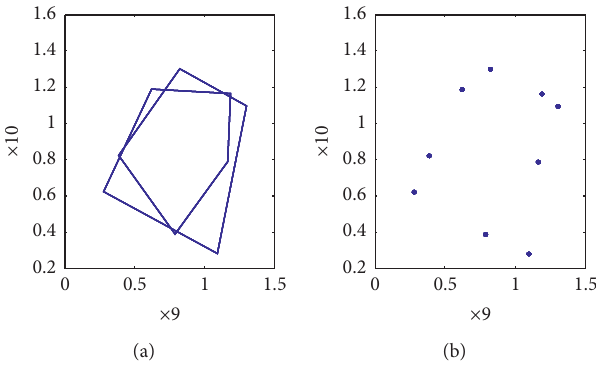
Figure 18: ω � 234 and k � 0 . 248 without random perturbation. w (a) Phase trajectories. (b) Poincare maps.